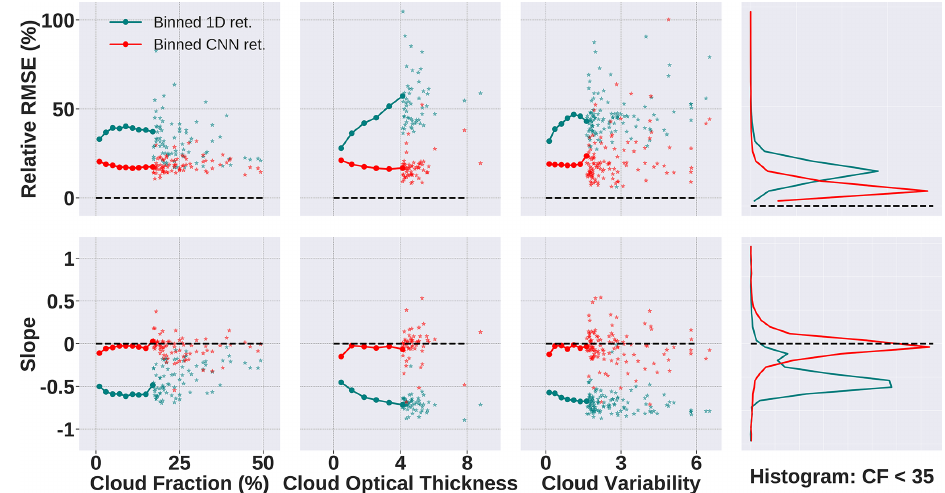
Figure 11. Comparison of CNN (shown in red) and IPA or 1D retrieval (shown in teal) obtained by methods described in Sect. 4.3. The CNN is trained on the gridded and sampled data set consisting of images from 1 × 1, 2 × 2, and 4 × 4 coarsening factor domains, and it is evaluated on a mix of unseen samples from all three domains. The dashed black line depicts the ideal